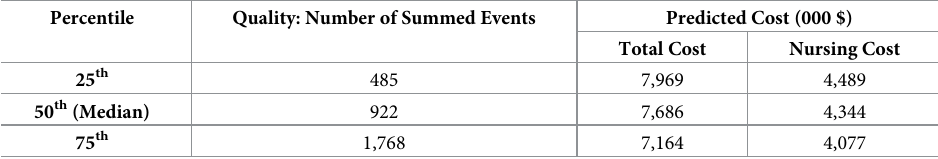
Table 6. Cost predictions at quartile measures of quality: Summed events measure of